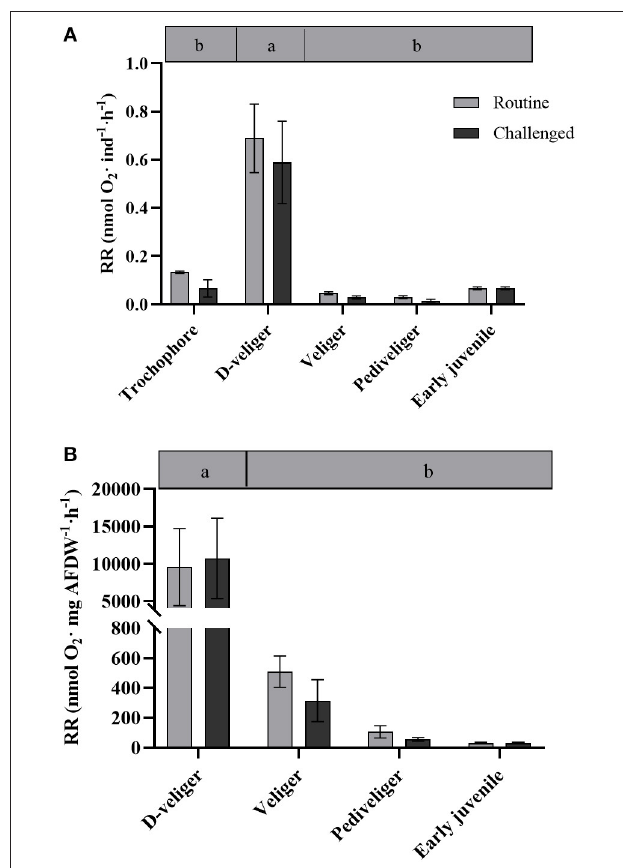
FIGURE 1 | (A) Respiration rate per individual (nmol O 2 ind − 1 · h − 1 ) and (B) per mass (nmol O 2 · mg AFDW · h − 1 ) throughout larval development and in early juveniles from the scallop Argopecten purpuratus. Different lowercase letters inside bars at the top of the graph indicate significant differences among developmental stages in basal conditions ( P < 0.05). n = 4 pools per